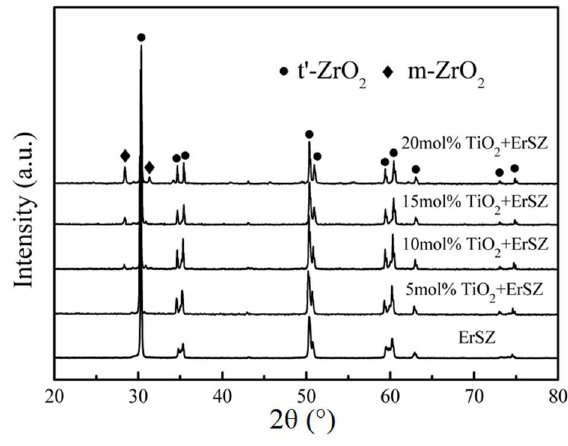
Figure 1. X-ray diffraction (XRD) patterns of the ErSZ pellet and the compounds doped with TiO 2